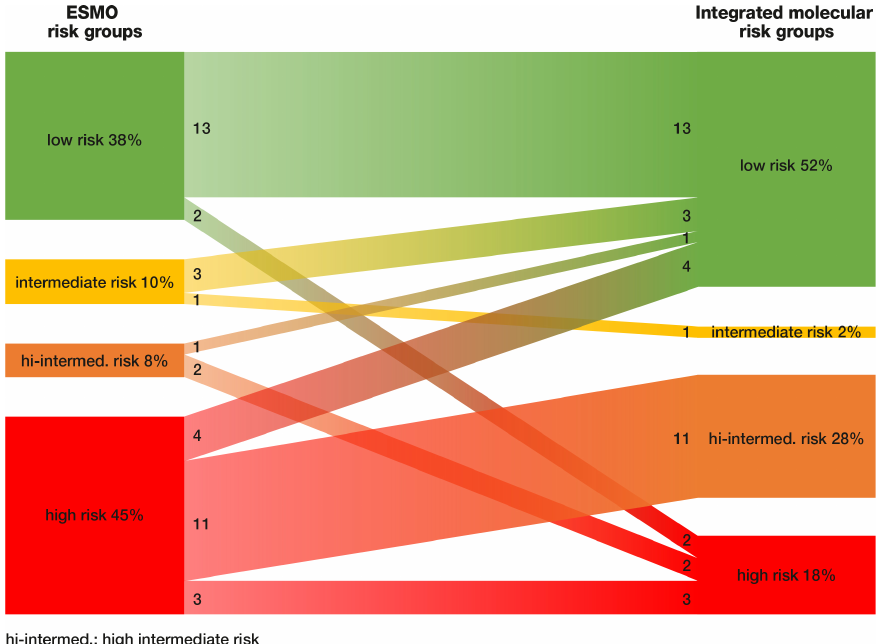
Figure 2. Shifts of patients between risk groups of two different stratification